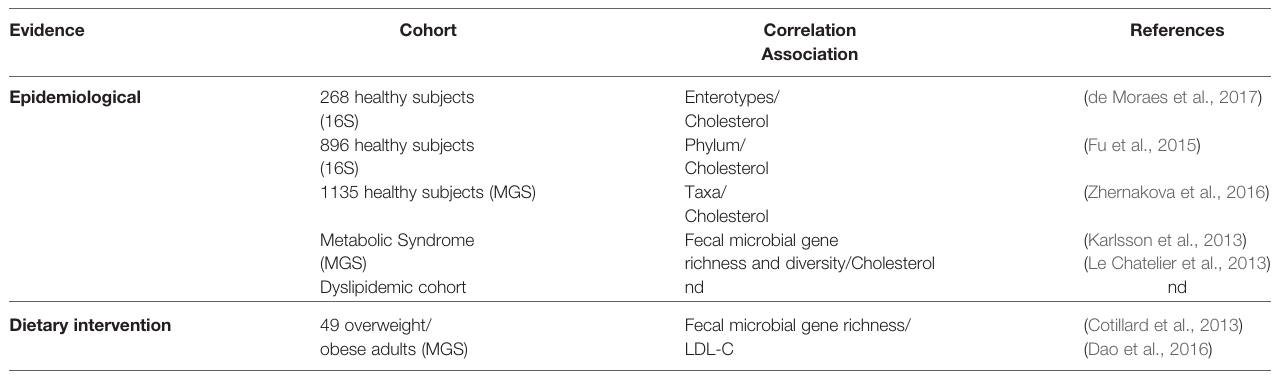
TABLE 1 | List of major clinical